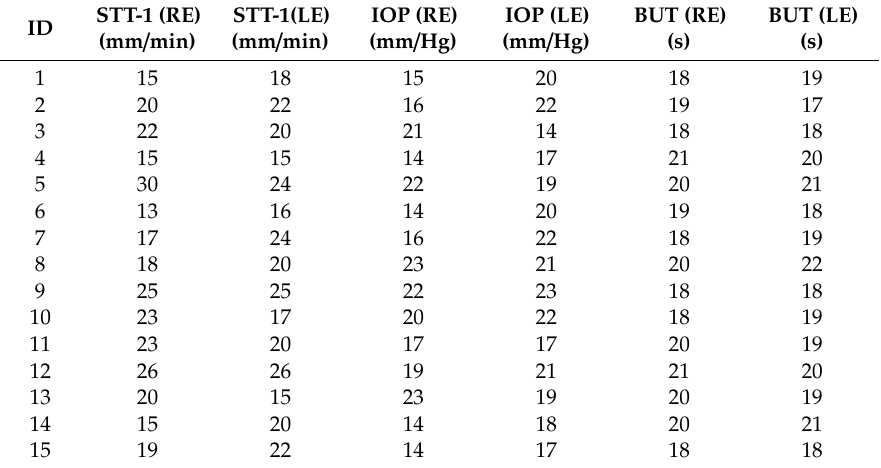
Table 3. Summary of ocular parameters